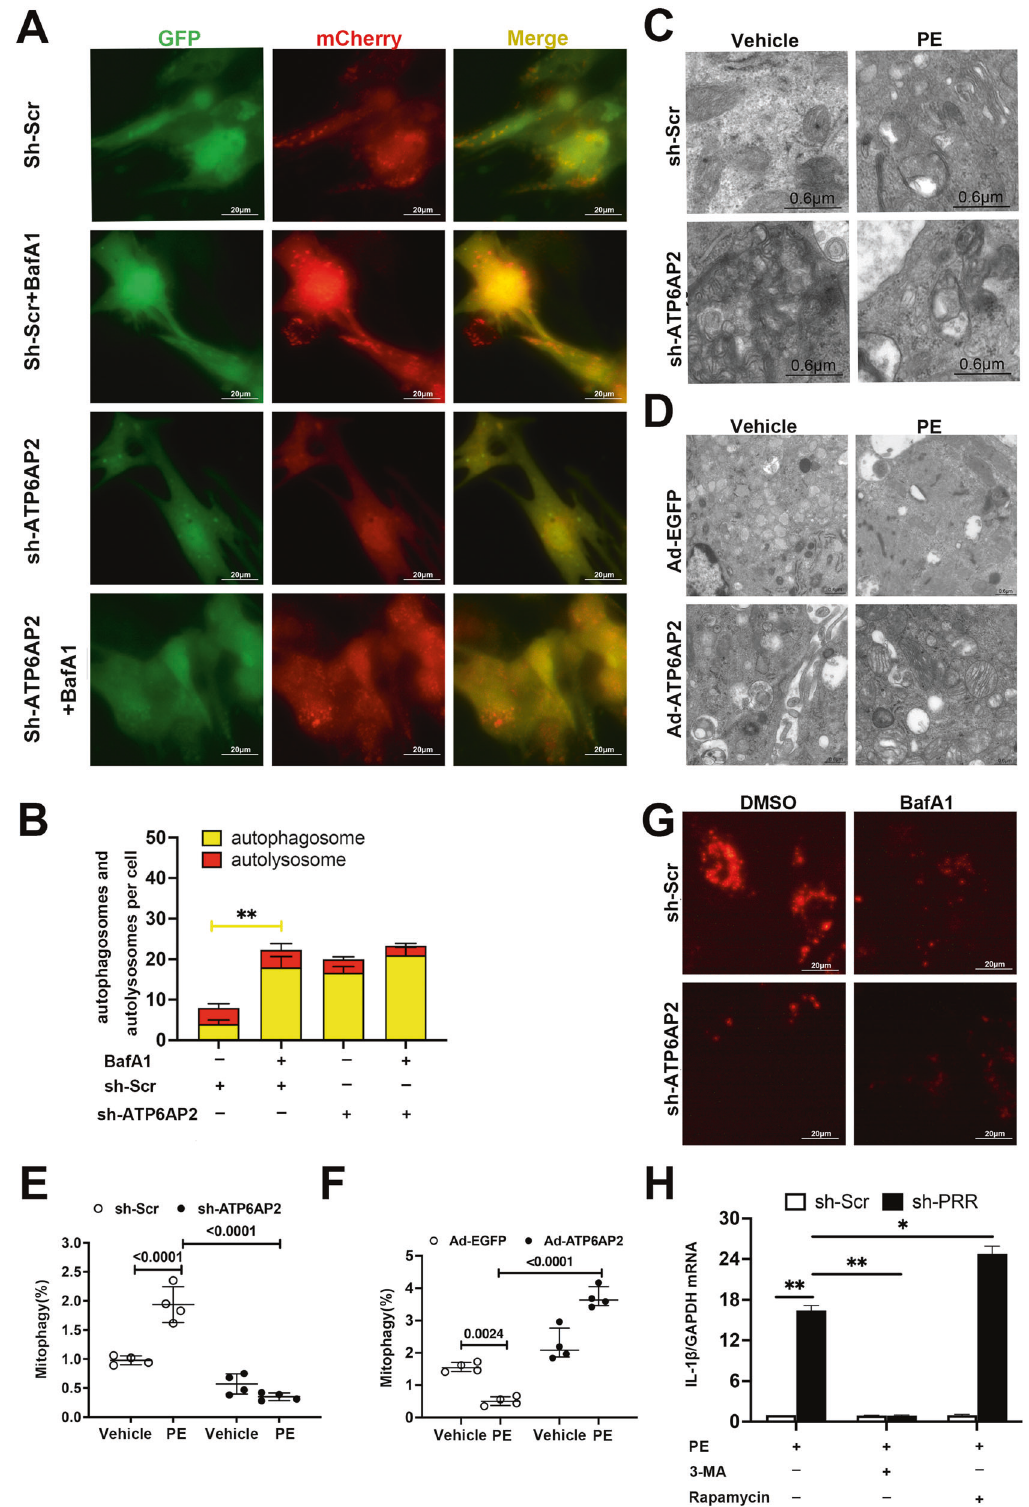
Quantitative RT-PCR Total RNA from tissue and culture cells was isolated using TRIZOL reagent. RNA was reverse transcribed with Prime Script RT Reagent Kit (Takara; RR037A). qRT-PCR was performed via Light Cycler 480 SYBR Green I Master (Roche; 04887352001). Expression levels of RNA were normalized to GAPDH. Primers for mouse gene expression are shown in the table Cell Death Discovery (2022)